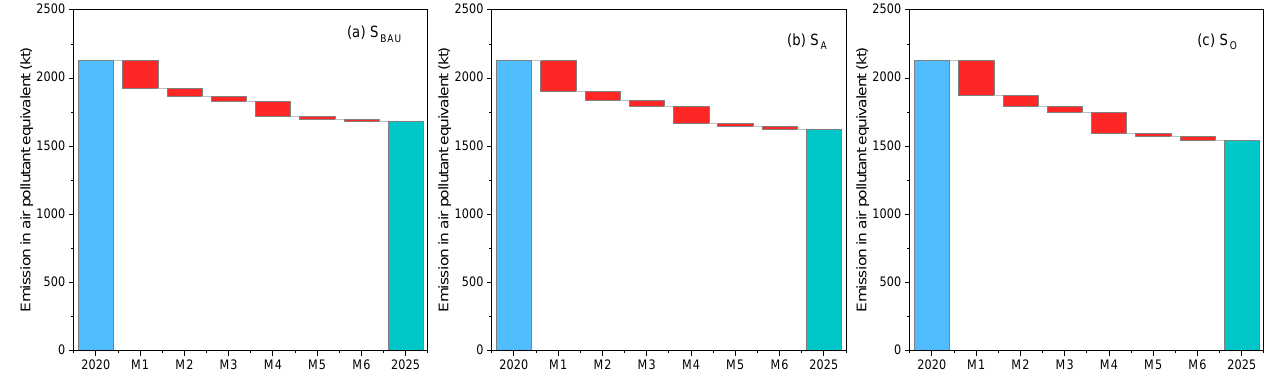
Figure 4. The contribution of different policy measures to emission reductions in 2025: ( a – c ) Air pollutant equivalent reduction from six measures in S BAU , S A and S O .